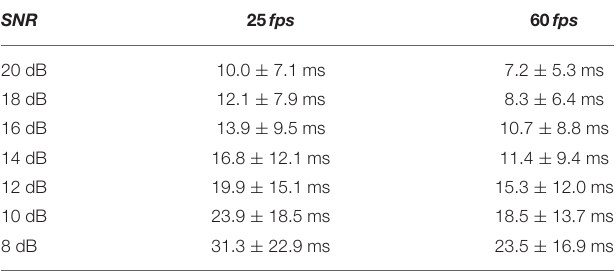
TABLE 1 | Mean absolute error ε and its standard deviation for two sampling frequencies f sample in dependency of the signal-to-noise ratio (SNR). SNR 25